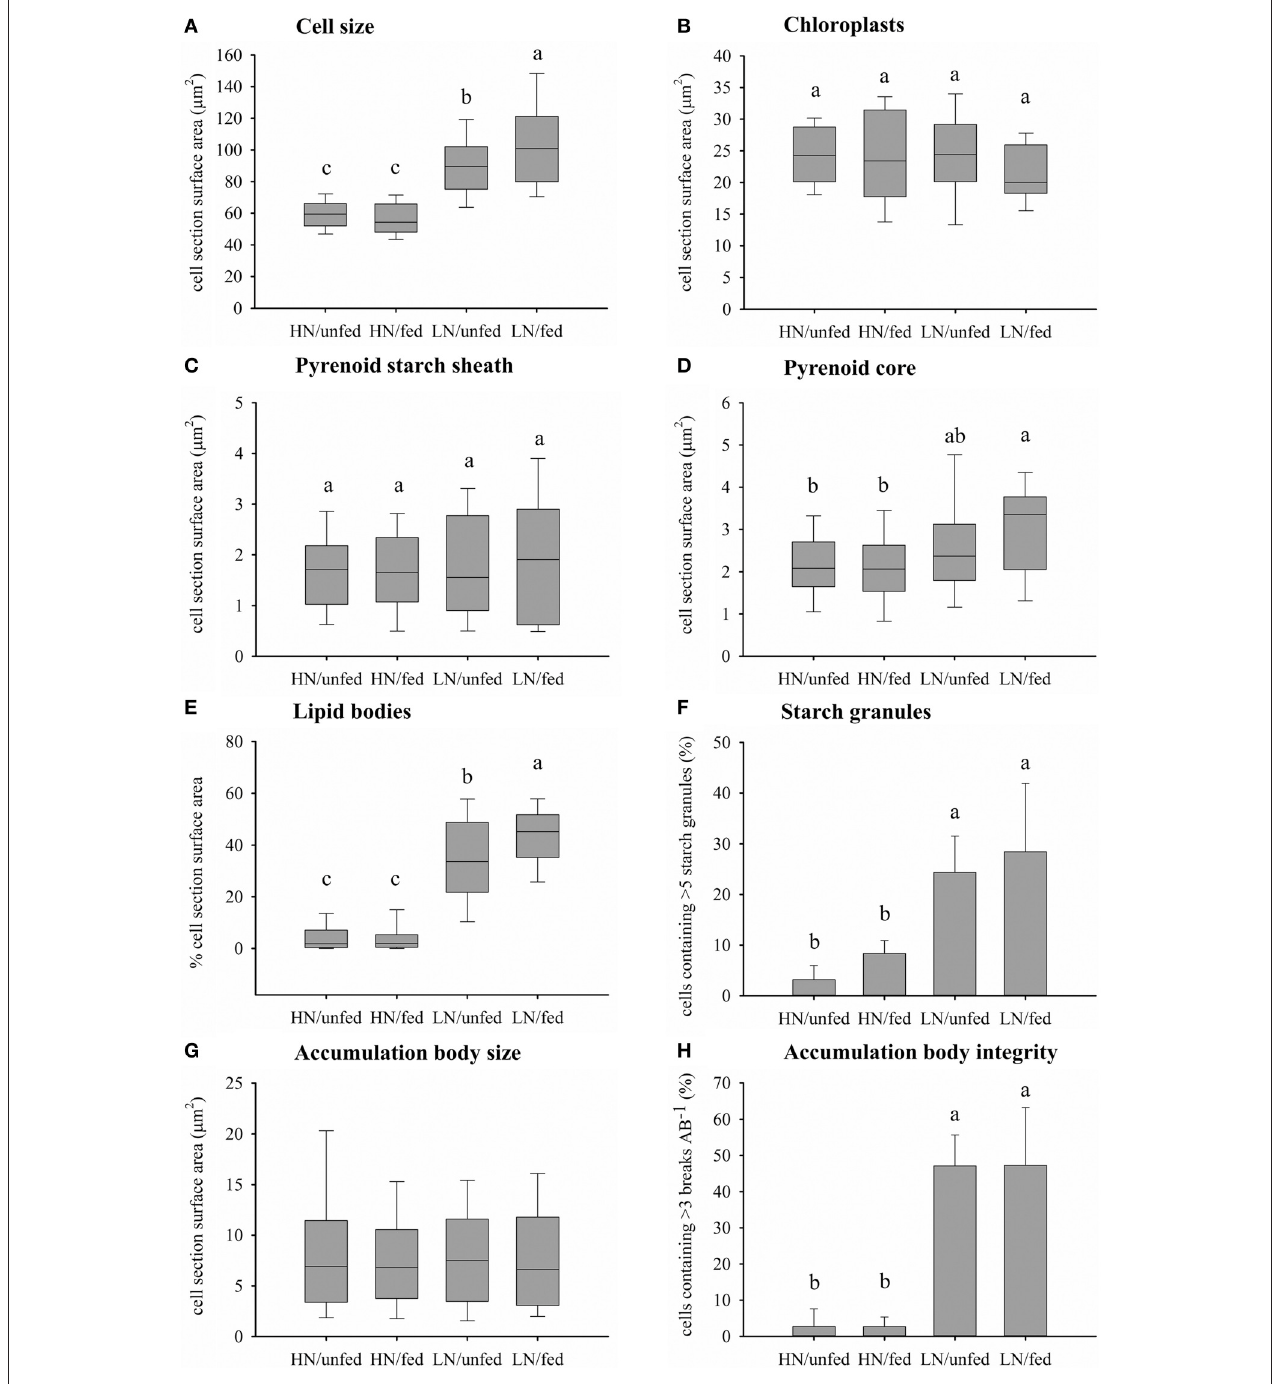
FIGURE 3 | Effects of the dissolved inorganic nutrient concentration and heterotrophic feeding on zooxanthellae cellular morphology. (A) Cell size measured as zooxanthellae section surface area ( µ m 2 ) ( n = 100 ). (B) Chloroplast abundance measured as section surface area ( µ m 2 ) ( n = 20 ). (C) Accumulation of starch around the pyrenoid measured as section surface area ( µ m 2 ) (HN/unfed n = 38 , HN/fed n = 32 , LN/unfed n = 22 , LN/fed n = 18 ). (D) Size of pyrenoid core measured as cell section surface area ( µ m 2 ) ( n = same as C ). (E) Accumulation of lipid bodies measured as per cent of cell section surface area ( n = 100 ). (F) Abundance of starch granules represented as per cent of cells containing greater than five starch granules ( n = 3 ). (G) Size of accumulation body measured as section surface area ( µ m 2 ) (HN/unfed n = 75 , HN/fed n = 81 , LN/unfed n = 39 , LN/fed n = 46 ). (H) Accumulation body integrity measured as the per cent of accumulation bodies containing greater than three breaks within their periphery ( n = 3 ). Box plots: the vertical line within each box represents the median. The box extends from the first to the third quartile and whiskers extend to the smallest and largest non-outliers. Outliers are not shown. Bar charts represent mean and SD. Statistically significant differences of pairwise comparison (Tukey’s post-hoc ) are indicated by the use of different letters.